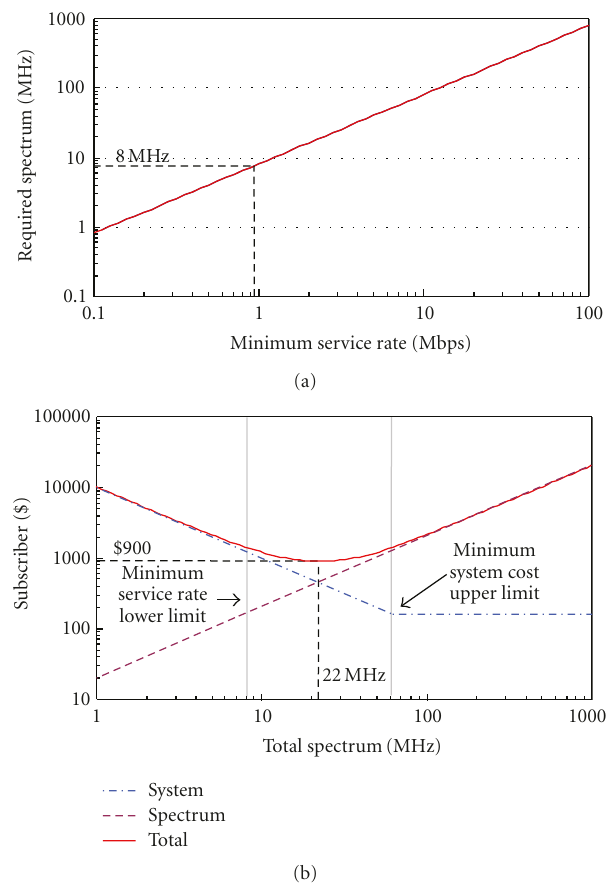
Figure 2: Example derivation. The minimum service rate spectrum requirements (a) sets a lower limit on the required spectrum (8MHz). The “knee” in the system cost (b) sets the upper limit on the usable spectrum (63MHz). The minimum total cost determines the persubscriber cost and required spectrum ($900, 22